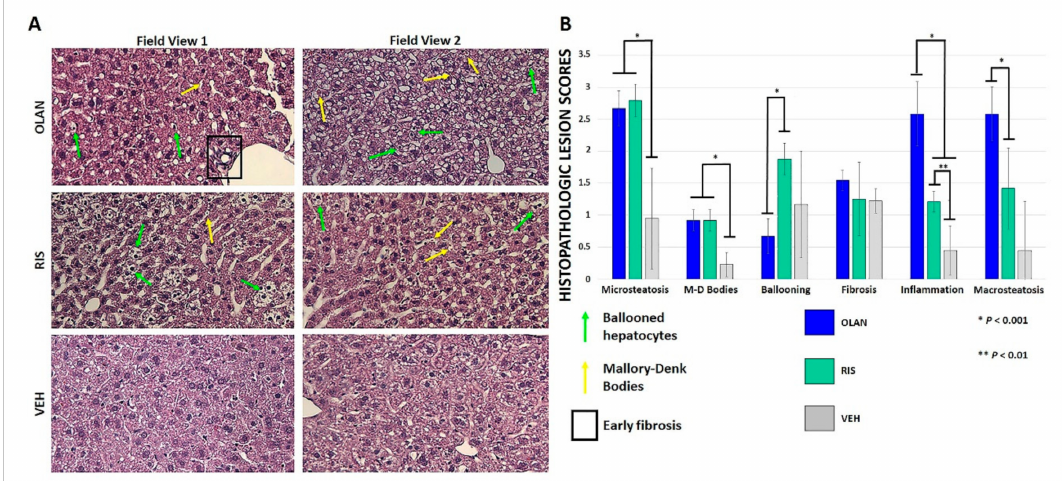
Figure 1. Atypical antipsychotic (AA) treatment led to histopathologic changes consistent with early non-alcoholic fatty liver disease (NAFLD). Hematoxylin and eosin staining showed several histopathologic changes at 20 × magnification following AA treatment relative to vehicle (VEH)-treated controls ( A ). These included micro- and macrosteatosis, ballooned hepatocytes (green arrows), Mallory–Denk bodies (yellow arrows), and small areas of early fibrosis (boxed). Two representative field views are shown. Statistical significance (*, **) in lesion scores between AA-treated mice and VEH-treated mice was found for microsteatosis, Mallory–Denk body formation, and formation of inflammatory foci ( B